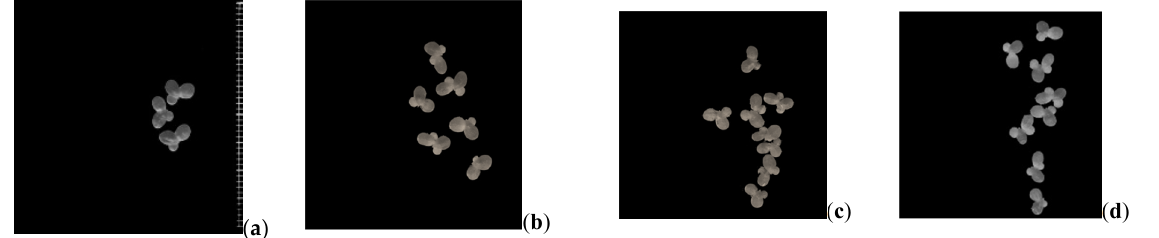
Figure 3. Appearance of the duckweed: initial ( a ); at the end of the experiment: control ( b ), 1000 Bq·L −1 : distilled water ( c ); water of the Yenisei River ( d ).